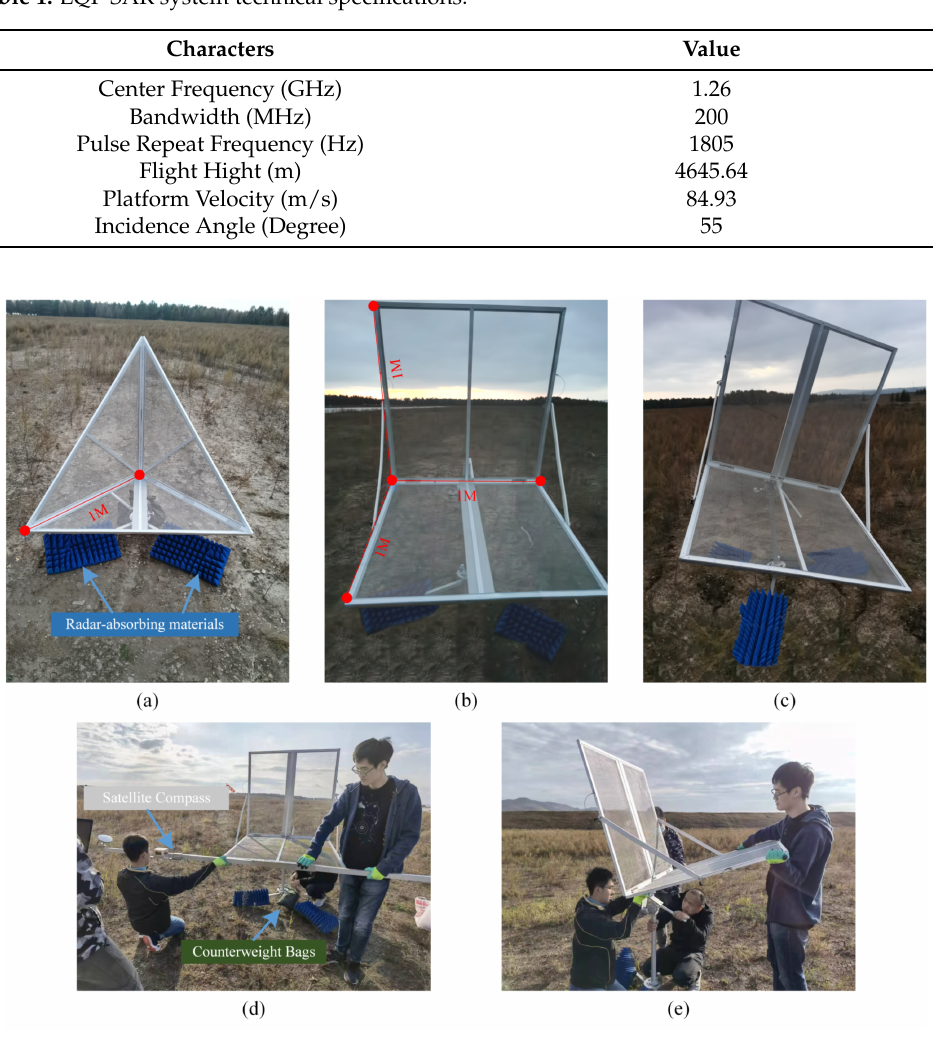
Figure 5. Ground-deployed CRs at Yudaokou Airport in September 2021: ( a – c ) trihedral CR, dihedral CR, and 22.5 ◦ rotated dihedral CR, respectively; ( d , e ) placement process and measuring